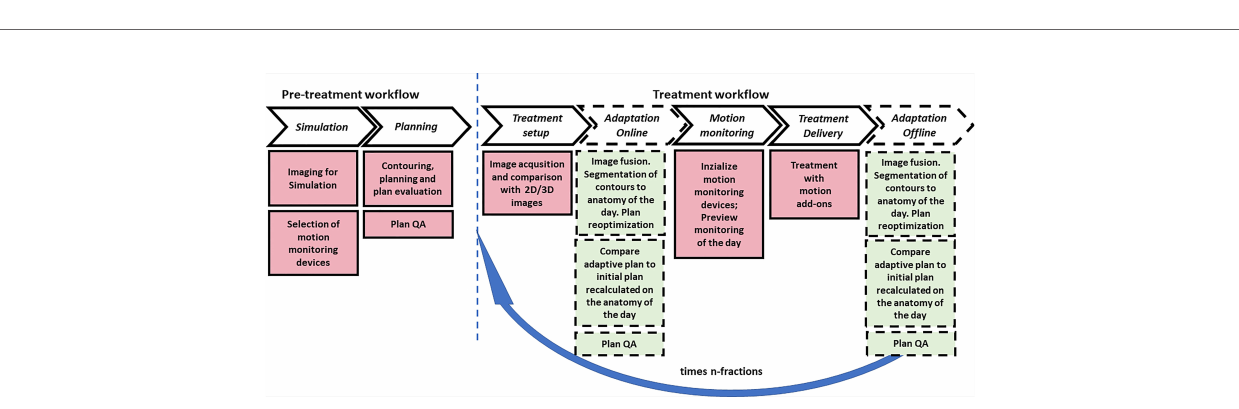
FIGURE 2 | Typical pretreatment and treatment PBT work fl ow with main subitems/tasks for motion management and anatomical change of organs and tumors. The dashed blocks indicate the online and off-line adaptation tasks that may be optionally applied one or more times during treatment. The blue arrow indicates the number of fractions in which the inter- and intra-fraction evaluation for motion management is